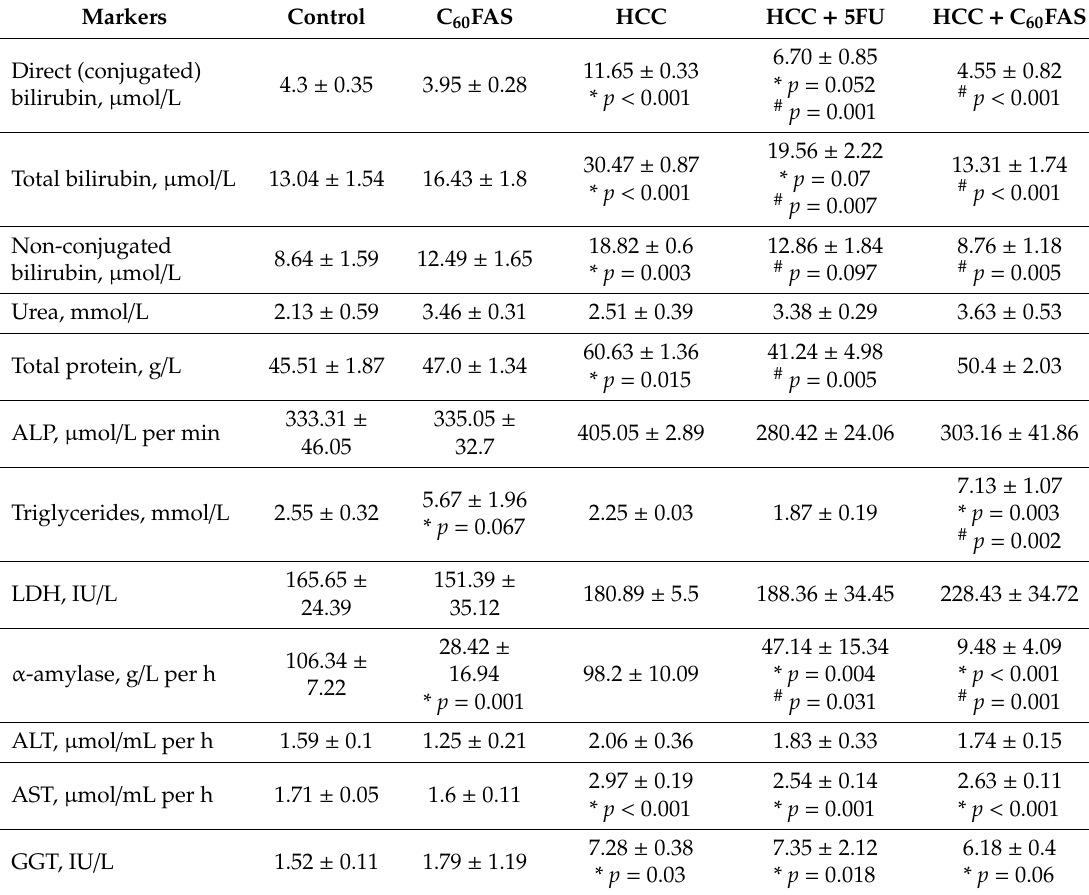
Table 2. Serum biochemical markers of HCC-rats treated by 5FU and C 60 FAS (M ±